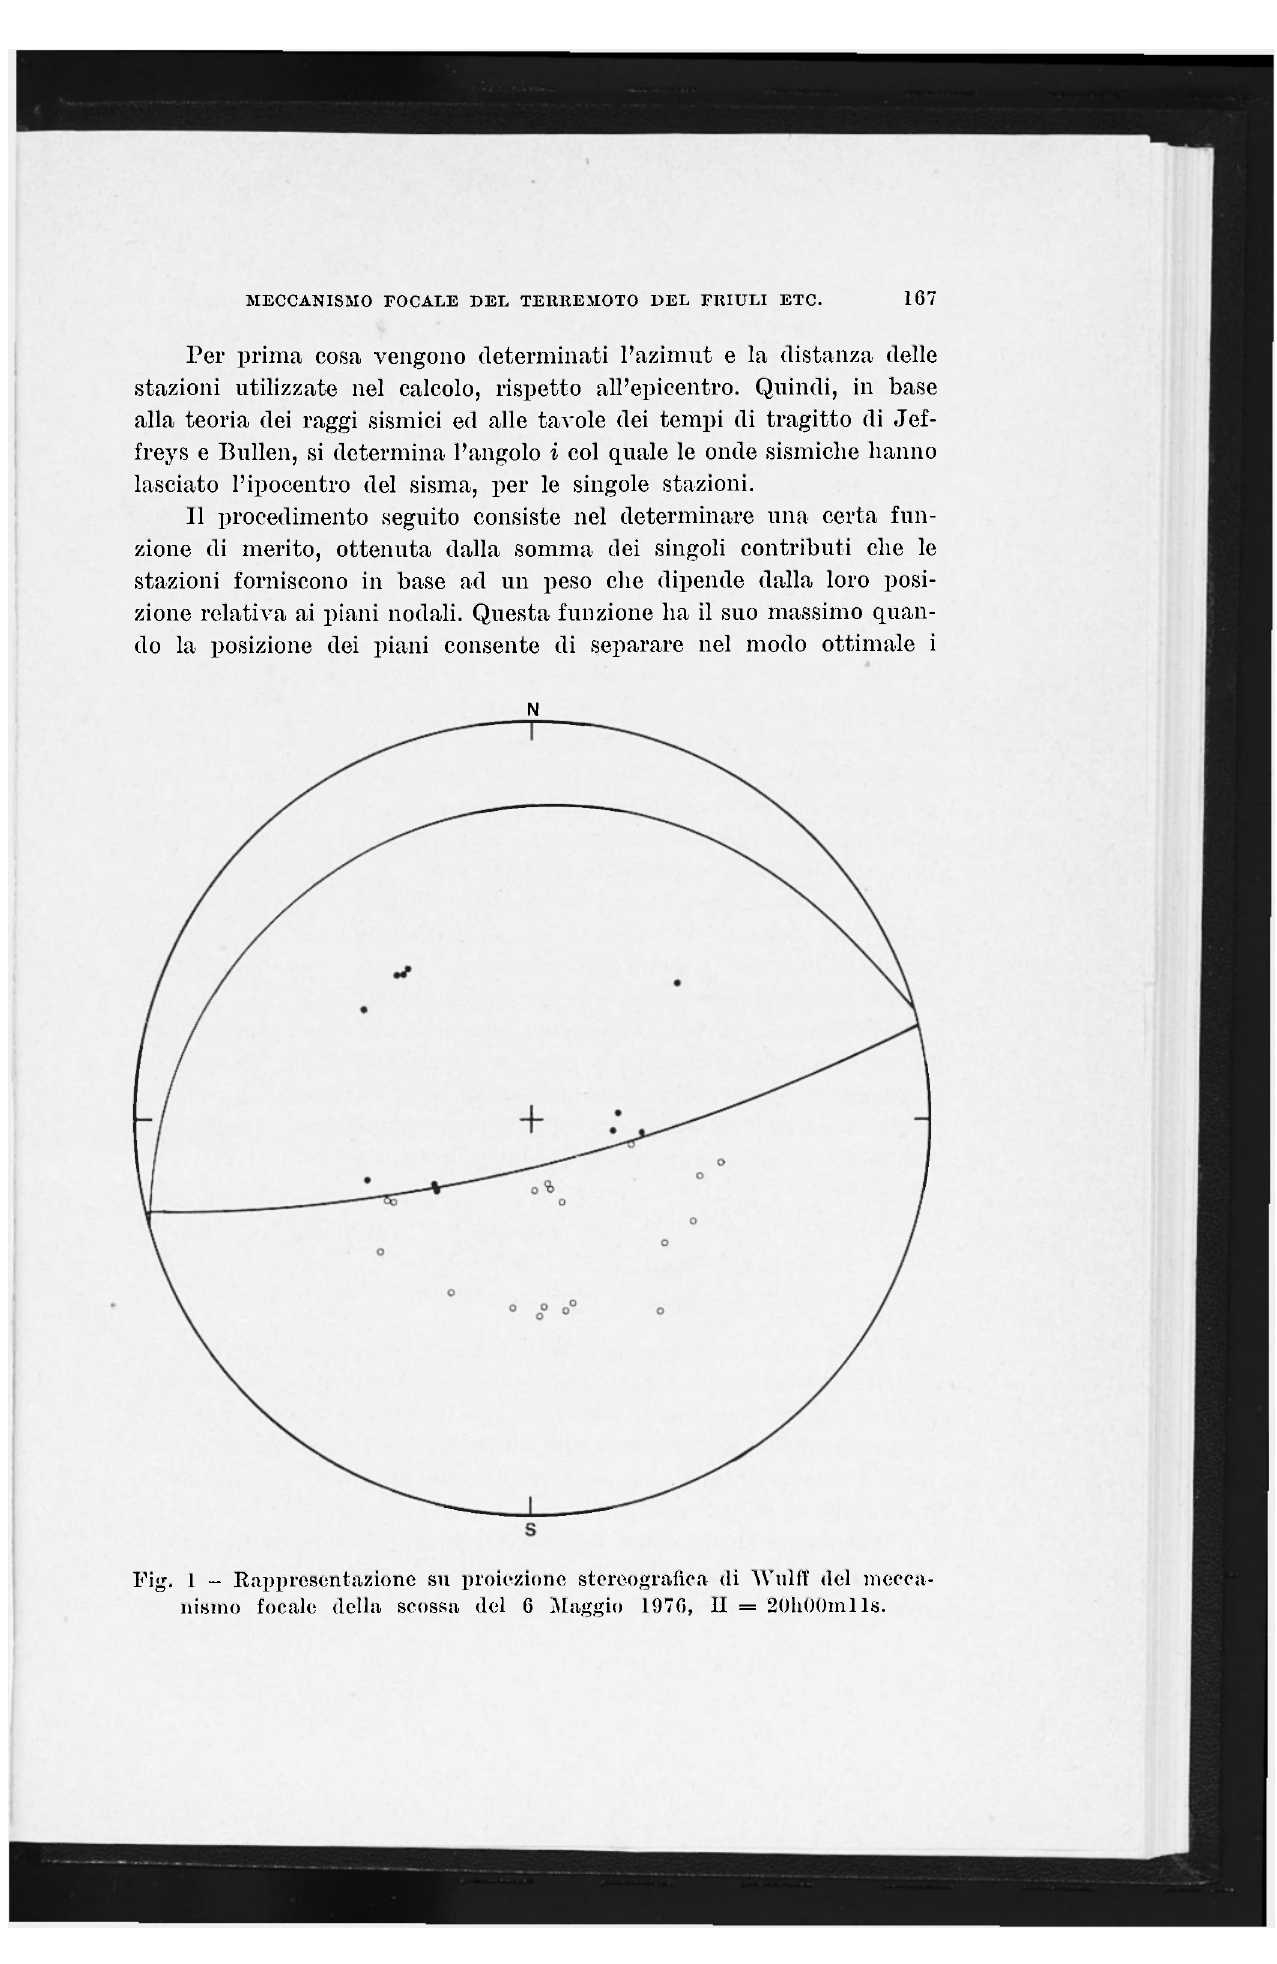
Fig. 1 - Rappresentazione su proiezione stereografica di Wulff del mecca- nismo focale della scossa del 6 Maggio 1976, II =